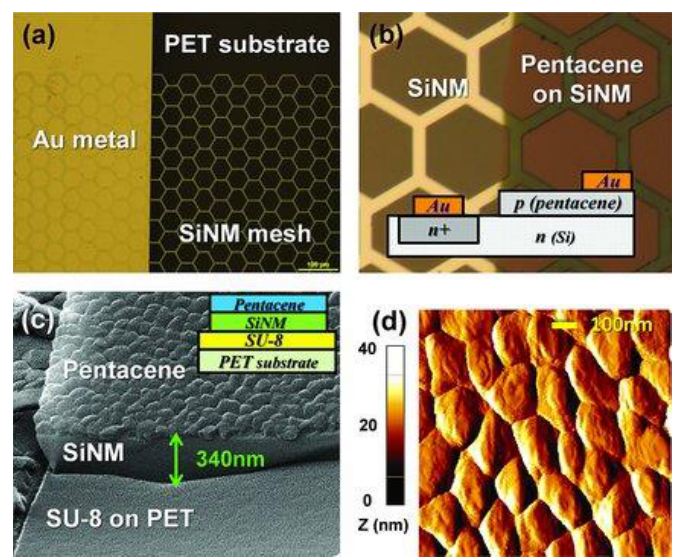
Figure 18. ( a ) Microscopic image of transferred Si NM grid on PET substrate. ( b ) Microscopic images of Si NM (left)/pentacene (right) heterojunction. The inset shows the cross-section of the heterostructure. ( c ) SEM image of Si NM and deposited pentacene layer sitting on SU-8-coated PET substrate. The inset shows the detailed layer structure. ( d ) AFM image of deposited pentacene on Si NM. The average pentacene grain size is 180 nm (reprinted from [42]).